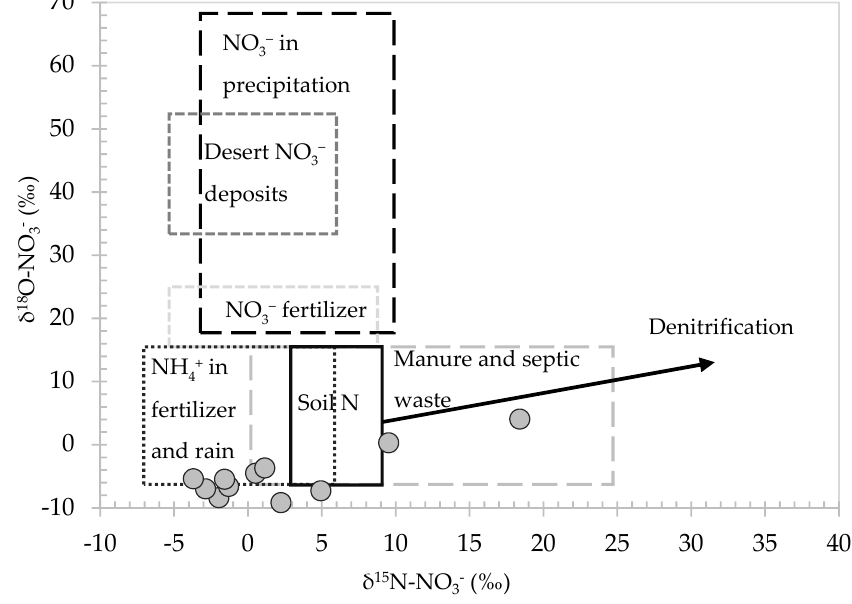
Figure 7. Determining sources of nitrogen in Dutch Flats area from oxygen and nitrogen isotopic ratios in nitrate. Figure labels are modified from Kendall [62].